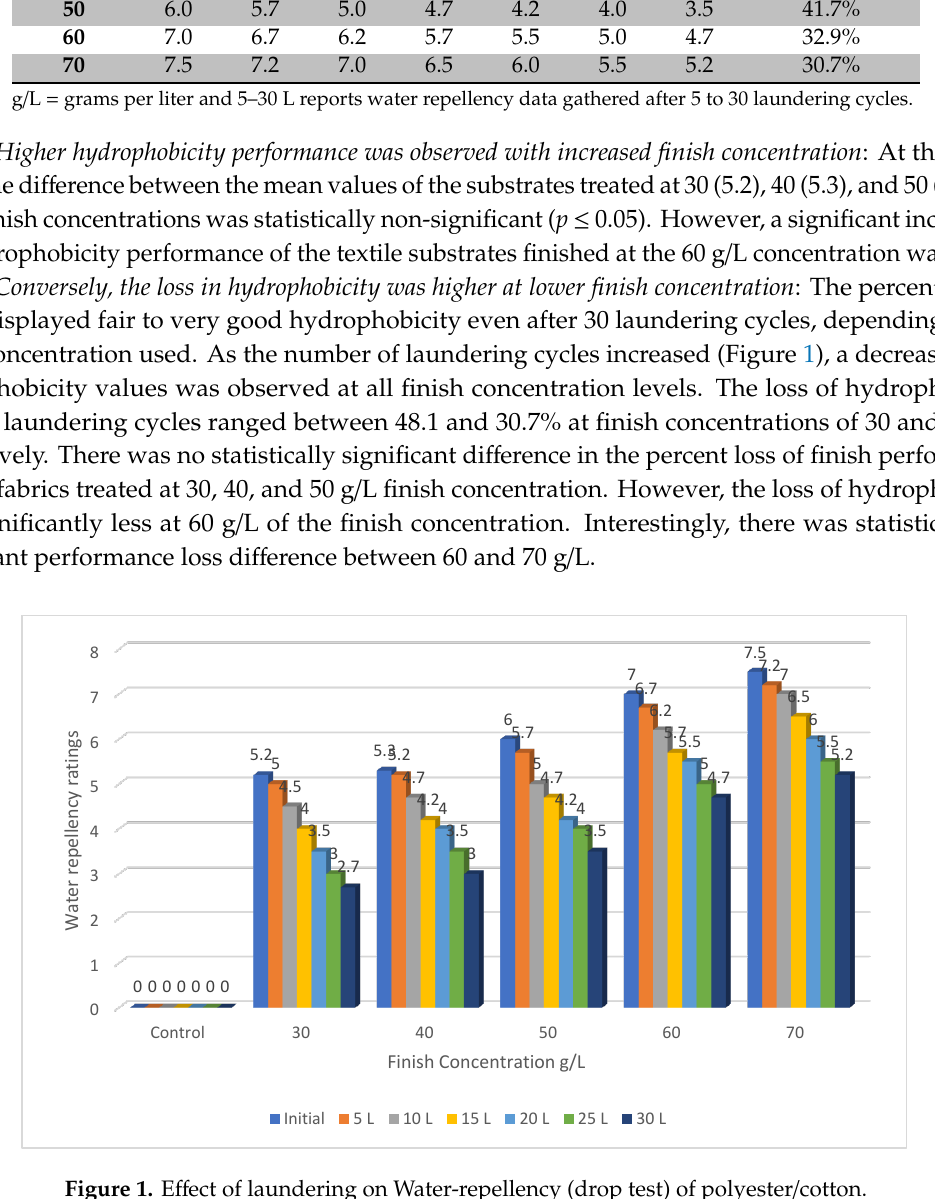
Figure 1. Effect of laundering on Water-repellency (drop test) of polyester/cotton. Figure 1. E ff ect of laundering on Water-repellency (drop test) of polyester /